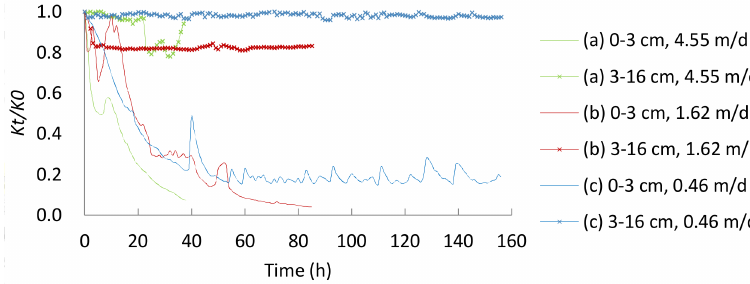
Figure 3. Permeability at different locations for flow velocities (V D